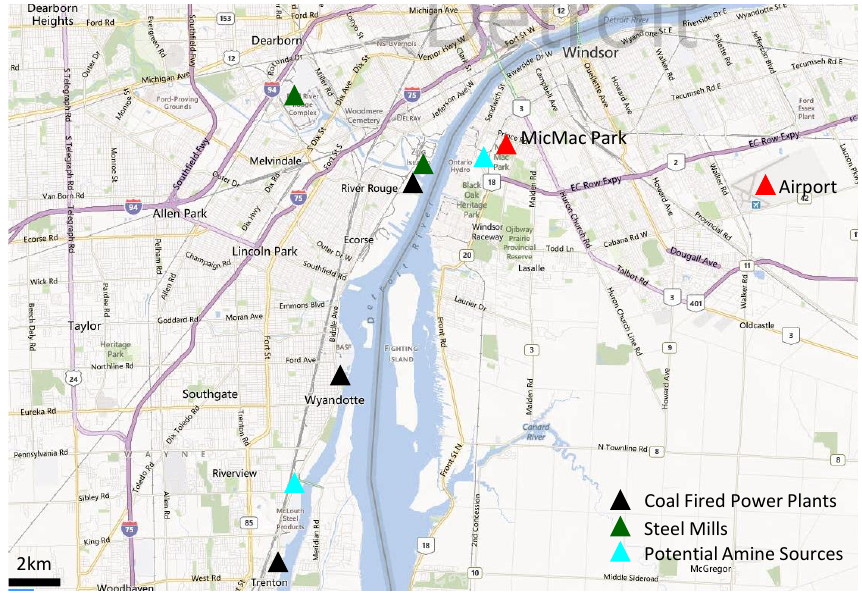
Figure 1. The location of the sampling site (MicMac Park) in Windsor, Ontario relative to major industrial sources, namely coal-fired power plants, steel mills, and potential large amine sources. It can be seen that the measurement site was located close to the largest international border crossing between the US and Canada (Huron Church Road and the Ambassador